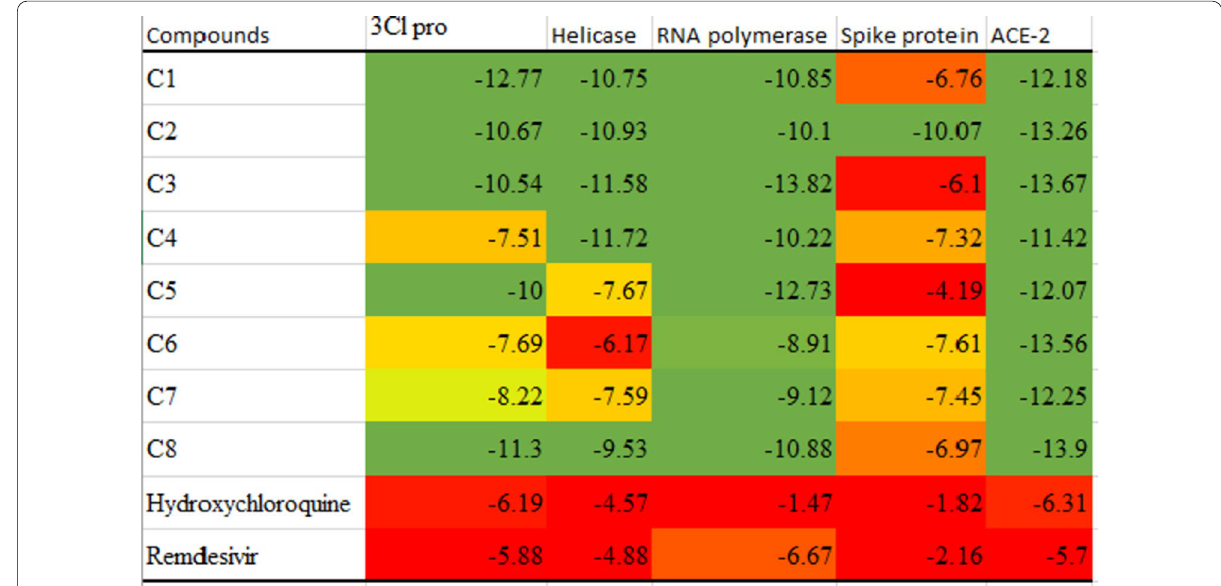
Fig. 3 Heat map of the docking scores of the top-scoring